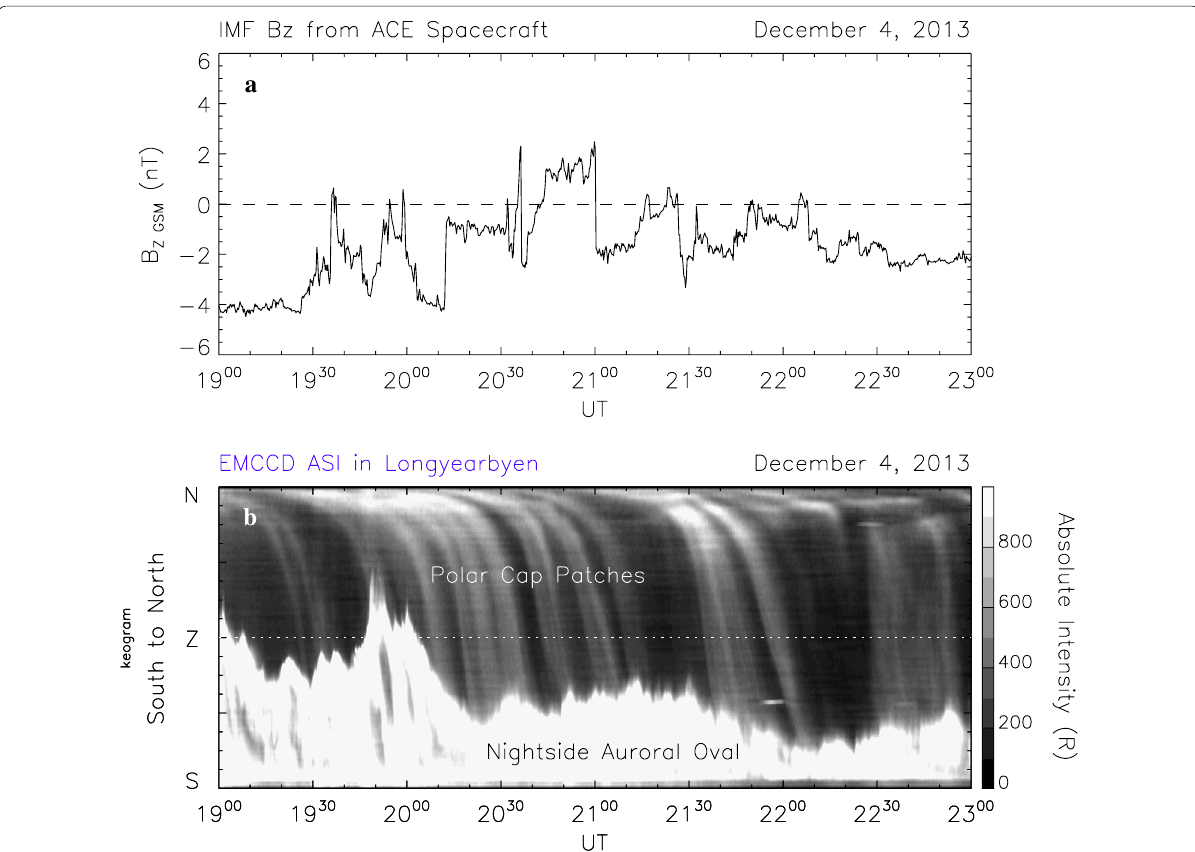
Fig. 1 Overview of an event of polar cap patches on December 4, 2013: a IMF B z obtained by the ACE spacecraft during a 4-h interval from 19:00 to 23:00 UT; b time-series of the south-to-north cross-section of the 630.0 nm airglow data obtained by the EMCCD